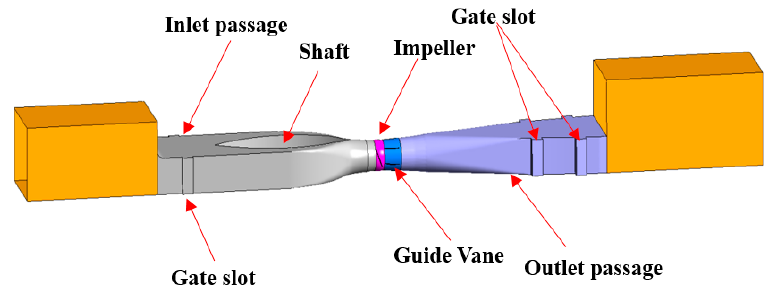
Figure 1. The front shaft tubular pumping device.